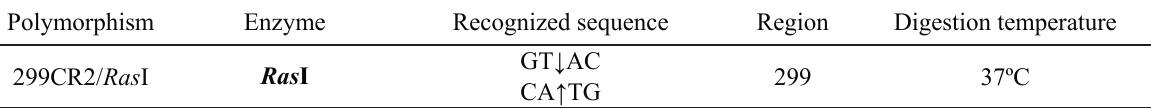
The restrictive enzyme used in the analysis of the genetic diversity of the mtDNA control region by ACRS-PCR